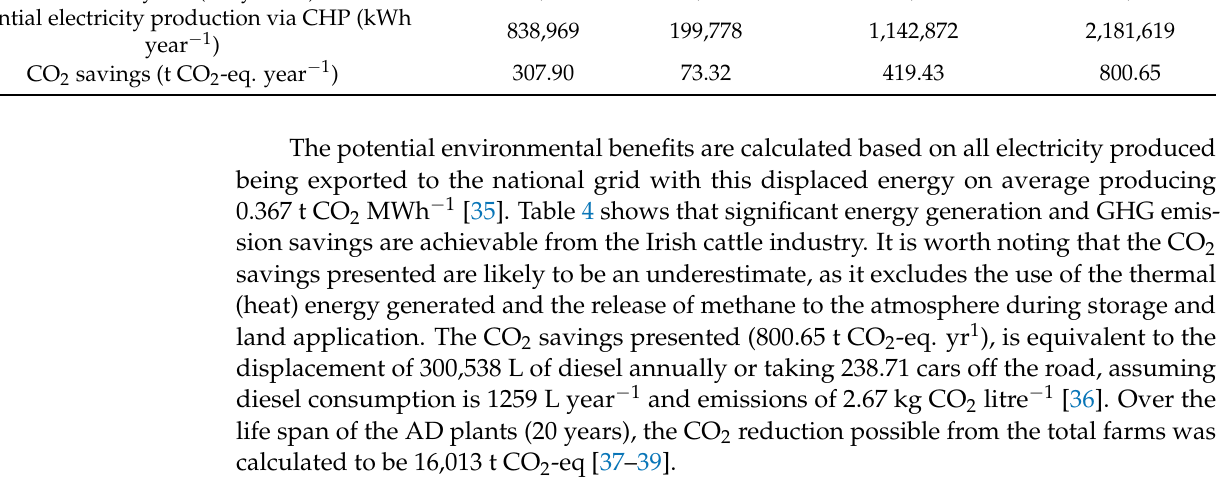
Table 4. Estimated feedstock availability and annual methane potential from “Likely Adopters” of AD. Dairy Farms Beef Farms Mixed Cattle Farms Total Farms Number of livestock